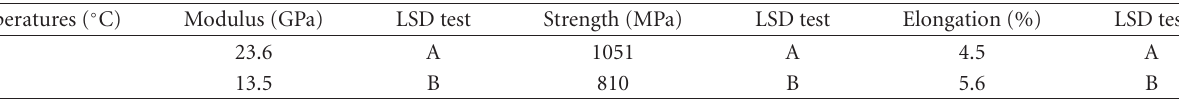
Table 4: Tensile properties of individual digested